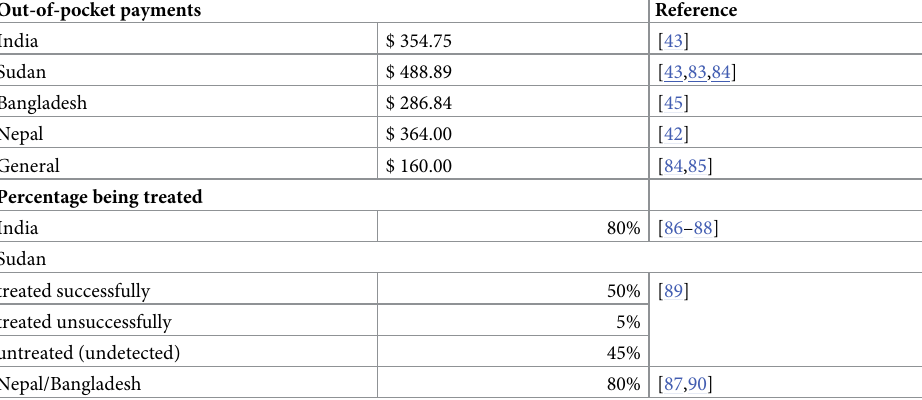
Table 3. Values used to calculate out-of-pocket payments (OPPs) for visceral leishmaniasis (I$—International